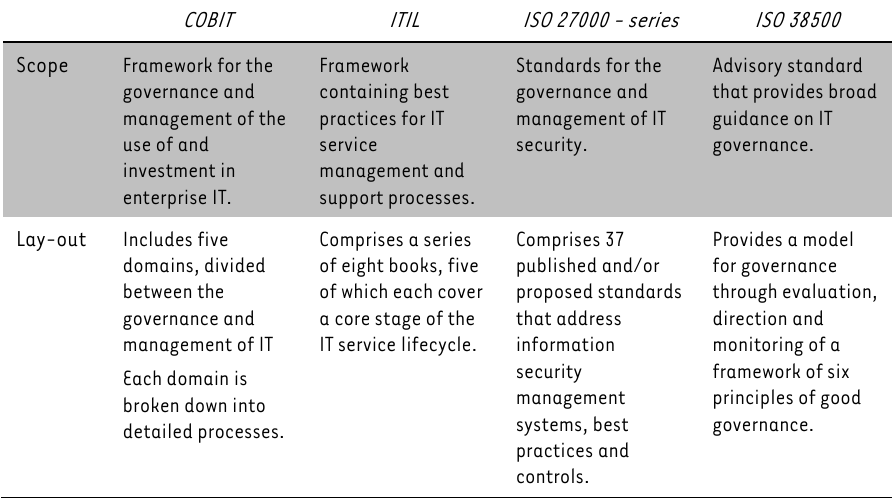
TABLE 1: The scope and lay-out of selected control frameworks and standards COBIT ITIL ISO 27000 -